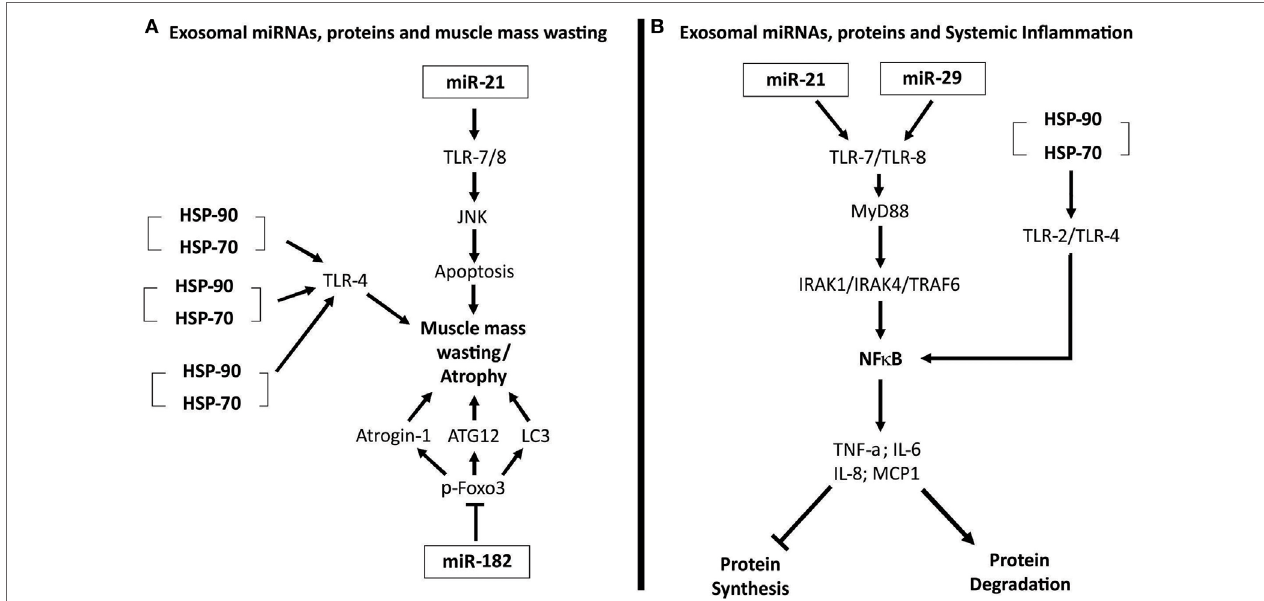
FiGURe 2 | (A) Exosomal microRNAs (miRNAs), proteins, and muscle mass wasting. miR-21 interacts with and activates toll-like receptor 7 (TLR-7). TLR-7, through the c-Jun N-terminal kinase pathway (JNK) pathway, induces apoptosis of muscle cells, leading to atrophy (32). Heat shock protein 70 (HSP70) and HSP90 that compose the membrane of exosomes can bind to TLR-4, activating this receptor on muscle cells and induce the muscle mass wasting (11). Exosomal miR-182 is able to block transcript factor Foxo3’s action, inhibiting its action, reducing the expression of several atrophy genes, as light chain 3 (LC3), Atrogin-1, and ATG12 (58). (B) Exosomal miRNAs, proteins, and systemic inflammation. miR-21 and miR-29 are able to interact and activate TLR-7/8–MyD88–nuclear factor kappa B (NF κ B) pathway, inducing an increased expression and release of pro-inflammatory cytokines tumor necrosis factor alpha (TNF- α ), interleukin-6 (IL-6), IL-8, and MCP-1 (59, 60). This pro-inflammatory state enhances protein degradation and inhibits protein synthesis. HSP70 and HSP90 present in exosomes membranes can bind to, and activate TLR-2 and TLR-4. When activated, these receptors promote the activation of the NF κ B pathway, inducing a pro-inflammatory status